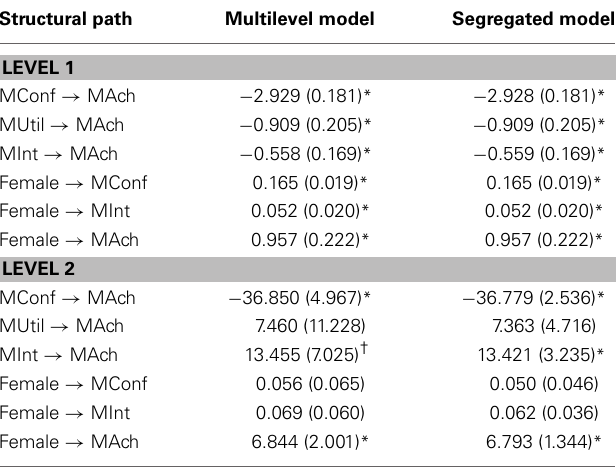
Table 2 | Estimated two-level path model of mathematics motivation, gender, and achievement (Model C